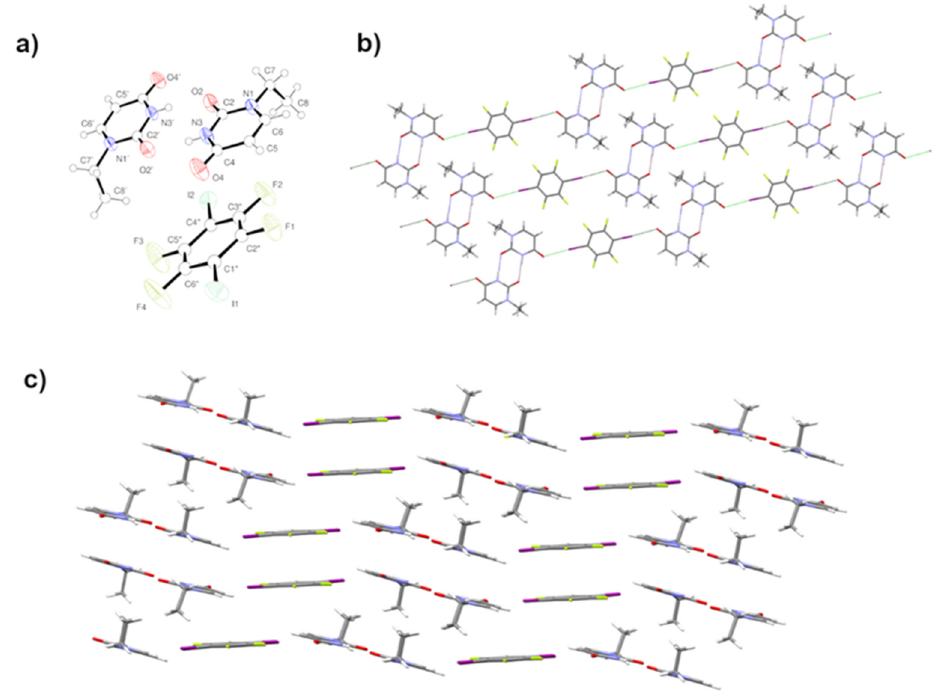
Figure 3. ( a ) ORTEP view of cocrystal 2 showing atom labeling in the asymmetric unit. ( b ) Planes formed by 1-ethyluracil–TFDIB molecules through H-bond and X-bond interactions. ( c ) 3D structure in cocrystal 2 .